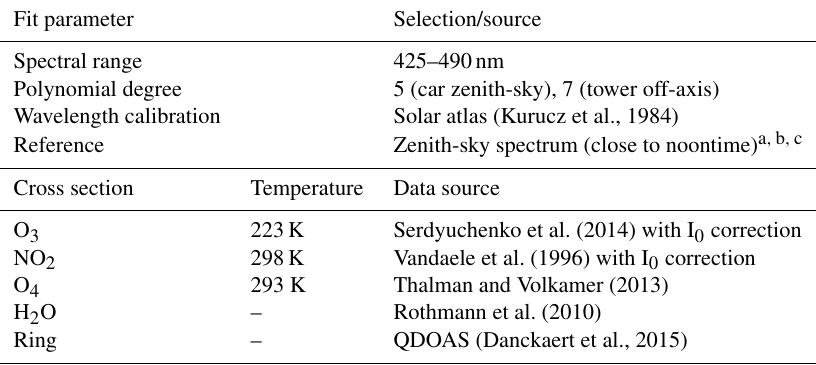
Table 2. DOAS settings for the retrieval of NO 2